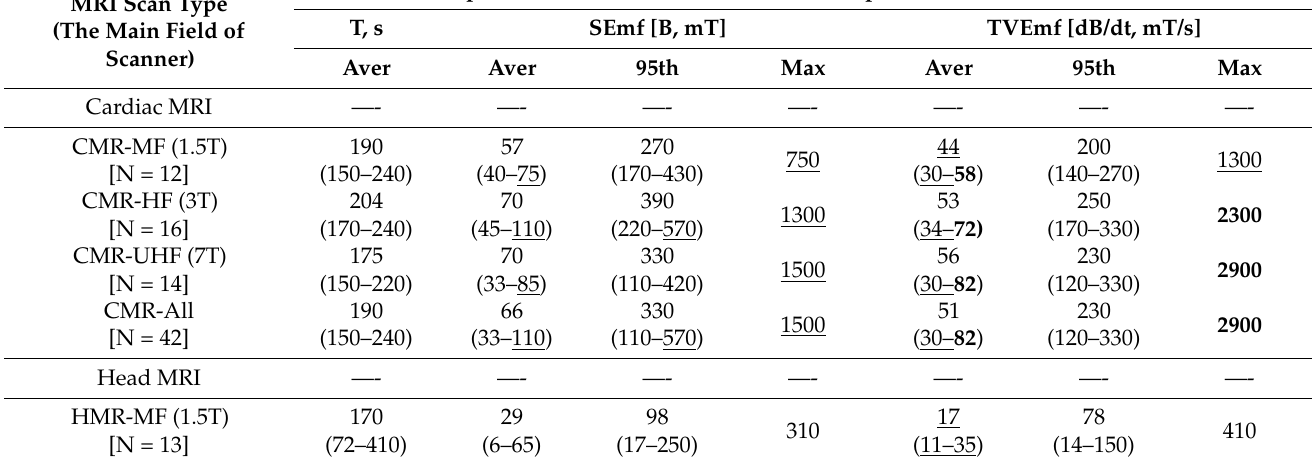
in Table 3: (i) parameters of samples in a single REE; (ii) parameters of REEs split into subsets of REEs collected near a single magnet type; and (iii) parameters of all samples recorded near a single magnet type (considered as a single combined set of samples). Table 3. Exposure to STmf related to CMR and head MR activities of radiographers near various MRI